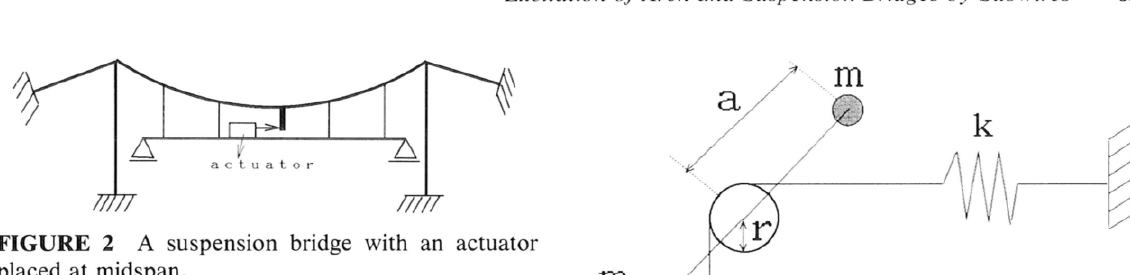
FIGURE 2 A suspension bridge with an actuator placed at midspan.